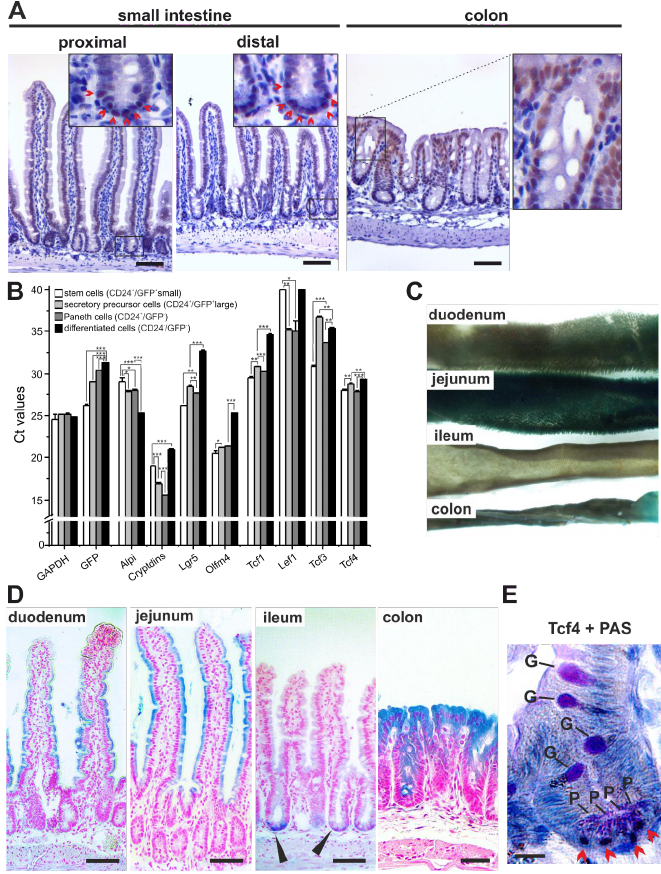
Figure 1. Differential pattern of Tcf4 expression in the mouse small intestine and colon. ( A ) Immunohistochemical detection of endogenous Tcf4 in the proximal and distal parts of the small intestine and colon. The Tcf4 nuclear positivity is indicated by 3,3′ -diaminobenzidine (DAB) stain (brownish nuclear precipitate). The specimens were counterstained with hematoxylin (blue nuclei). Magnified images are shown in the insets. Tcf4-positive cells were detected in the crypts of both proximal and distal parts of the small intestine (red arrowheads), and in the upper portion of the colonic epithelium. ( B ) Quantitative reverse transcription polymerase chain reaction (qRT-PCR) analysis of Lef/Tcf gene expression in cell populations isolated from the small intestinal crypts of Lgr5- CreERT2 mice. Cells were sorted according to their size and green fluorescent protein (GFP) or cluster of differentiation 24 (CD24) positivity to stem cells (CD24 + /GFP + small cells), secretory precursor cells (CD24 + /GFP + large cells), Paneth cells (CD24 + /GFP − cells) and differentiated cells (CD24 − /GFP − cells). The diagram shows the threshold cycle (Ct) values normalized to β -actin ( Actb ) gene expression (the Actb gene Ct value was arbitrarily set to 21); GAPDH was — next to Actb — an additional housekeeping gene. The analysis was performed on cell populations obtained from three animals of the corresponding genetic background; qRT-PCR reactions were run in technical triplicates. Results of one representative experiment are shown; error bars indicate standard deviations (SDs); * p < 0.05; ** p < 0.01; *** p < 0.001 (Student’s t -test). Cryptdins indicate the expression of cryptdin 1,3,6–12,14,15 detected by a common primer pair. ( C ) Stereomicroscopy images of whole-mount detection of β -galactosidase (lacZ) in the intestine of Tcf4 lacZ/+ reporter mice. Specimens were developed using the 5-bromo-4-chloro-3-indolyl-beta- D -galactopyranoside (X-gal) substrate (blue stain). ( D ) Sections showing the lacZ activity on the villi of the duodenum and jejunum, in the crypts of the ileum (black arrowheads), and in the cells lining the colonic surface. Specimens were counterstained with fast nuclear red. ( E ) Immunodetection of nuclear Tcf4 (DAB stain; red arrowheads) in periodic acid-Schiff (PAS)-stained Paneth cells (P). Notice the PAS positivity (dark violet stain) in maturating goblet cells (G). The section was generated from the ileum of Tcf4 lacZ/+ mice upon lacZ visualization. Scale bar: ( A , C ) 0.1 mm; ( E ) 5 µ